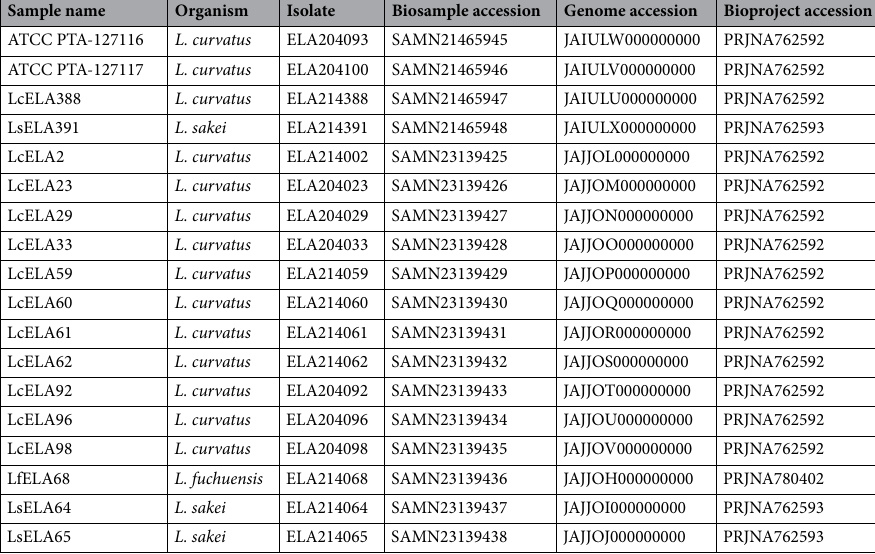
Table 1. Accession numbers for Latilactobacillus